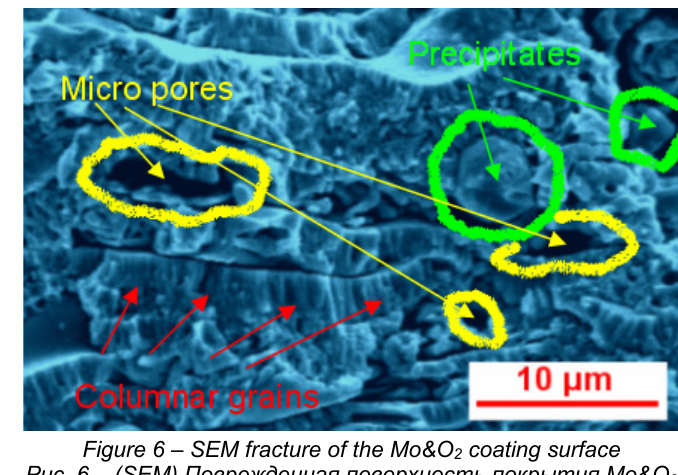
Figure 6 – SEM fracture of the Mo&O 2 coating surface Рис . 6 – (SEM) Поврежденная поверхность покрытия Mo&O 2 Слика 6 – (SEM) површина лома превлаке Mo&O